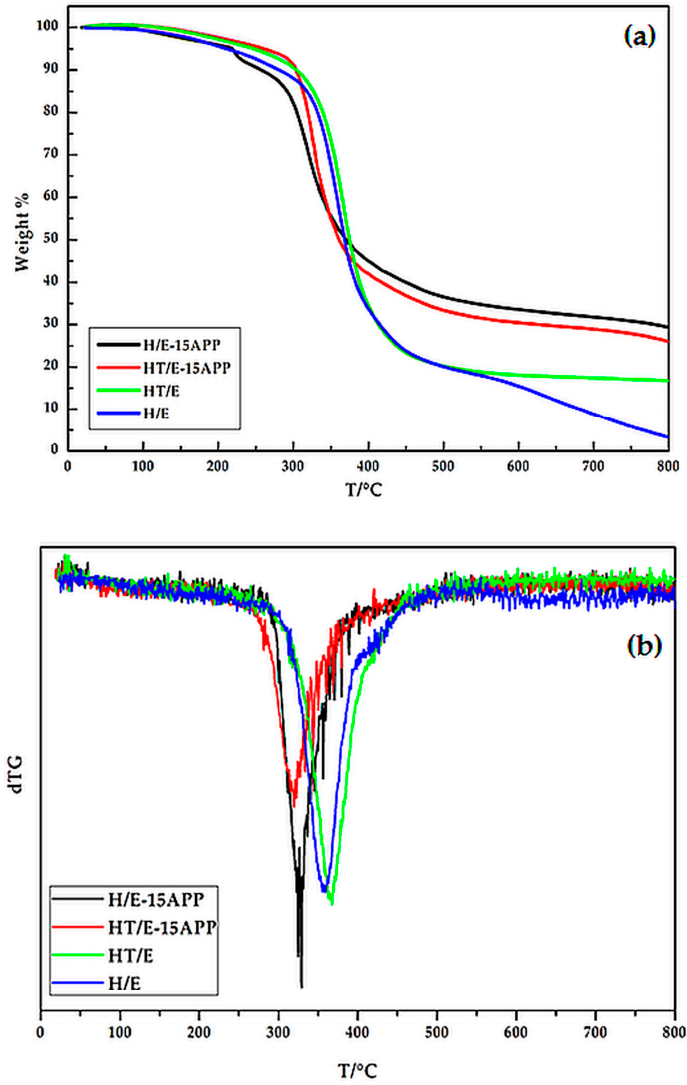
Figure 7. TG ( a ) and dTG ( b ) curves in an inert atmosphere for the investigated composite.